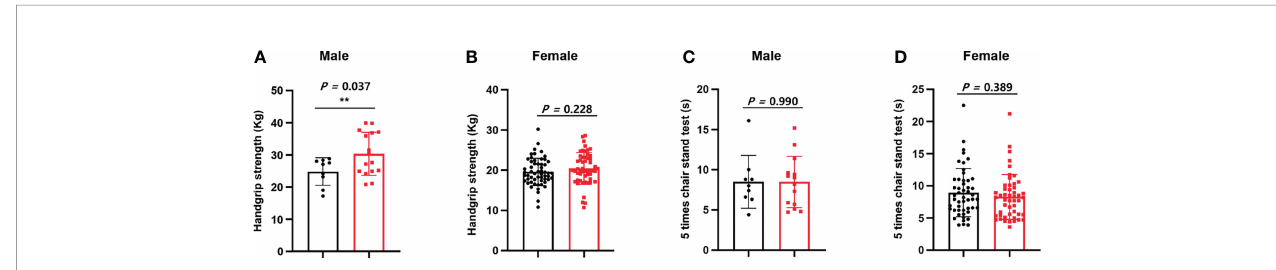
FIGURE 1 | Relationships of grip strength and chair-stand test result with serum TSH concentration and sex. (A) We allocated the participants to two groups on the basis of sex. Grip strength in men was signi fi cantly lower in the low-TSH group than in the high-TSH group. (B) However, grip strength in women was similar in the high-TSH and low-TSH groups. (C) The results of the chair-stand test were analyzed in the same way. The results of the test were similar in men in the high-TSH and low-TSH groups. (D) The results of the test were also similar in women in the high-TSH and low-TSH groups. ** in the fi gure indicates p-value < 0.01.